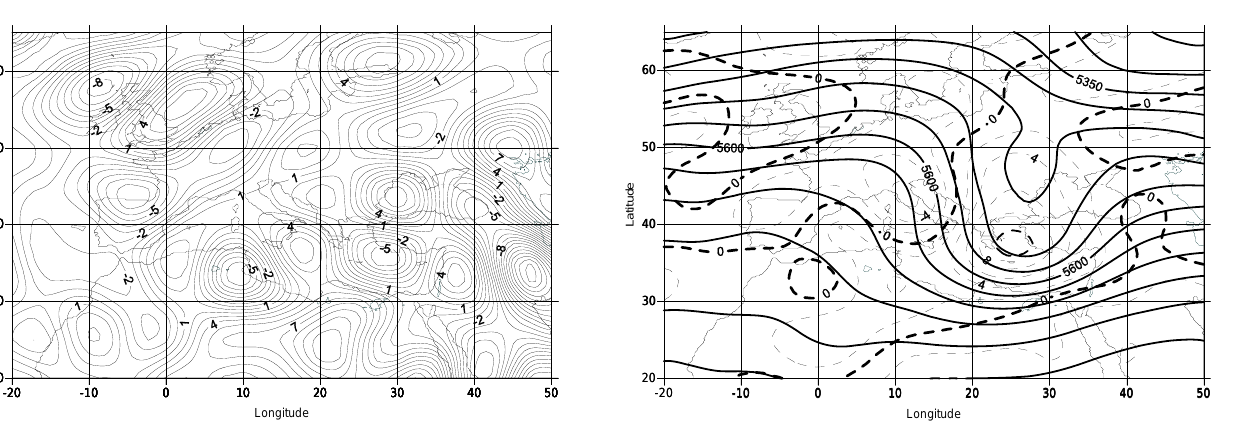
Fig. 8. Geopotential height (solid lines, gpm) over the 500hPa iso-